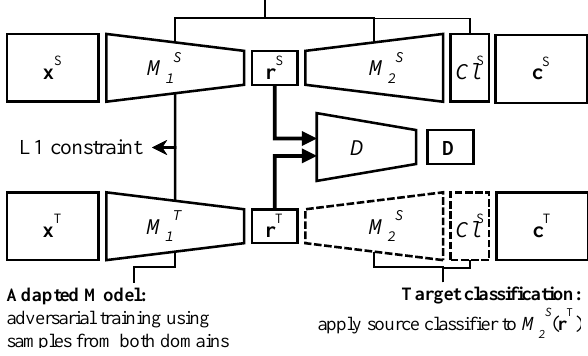
Figure 2. Concept of adversarial domain